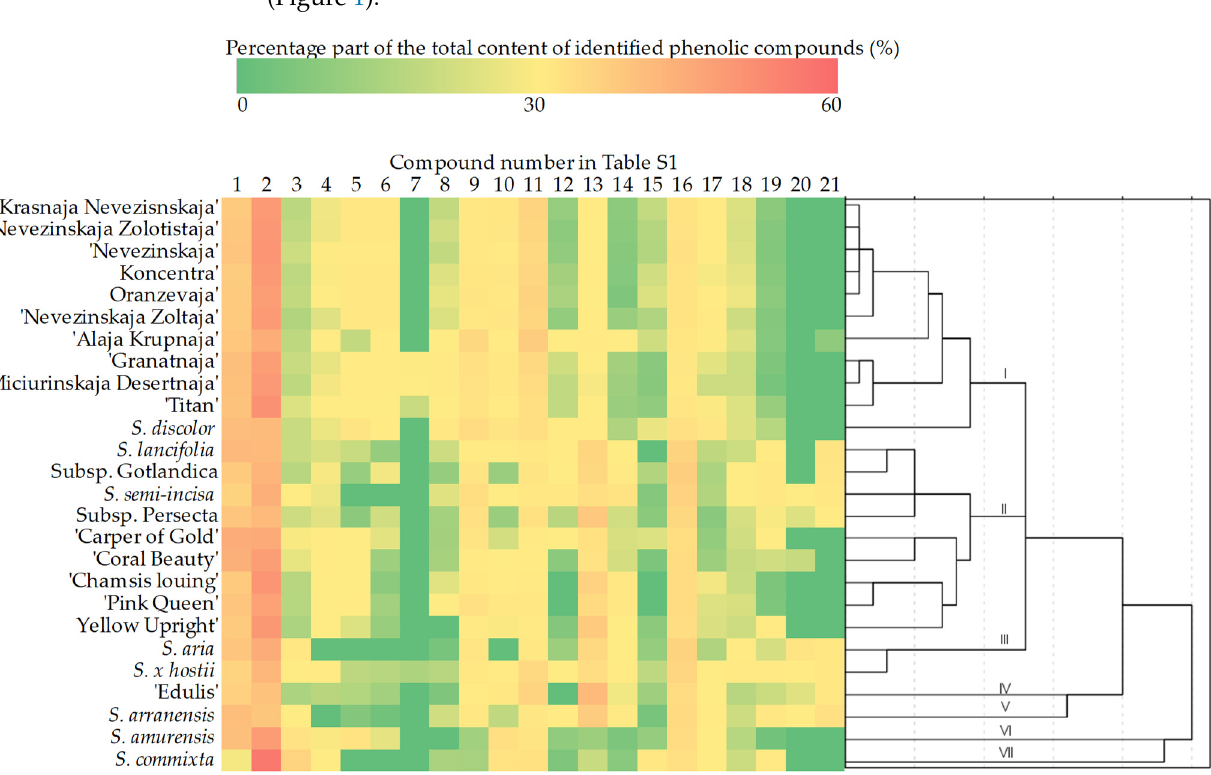
Figure 1. Dendrogram of hierarchical cluster analysis of Sorbus inflorescence samples according to the phytochemical composition and heatmap of the percentage compositions of identified phenolic compounds: